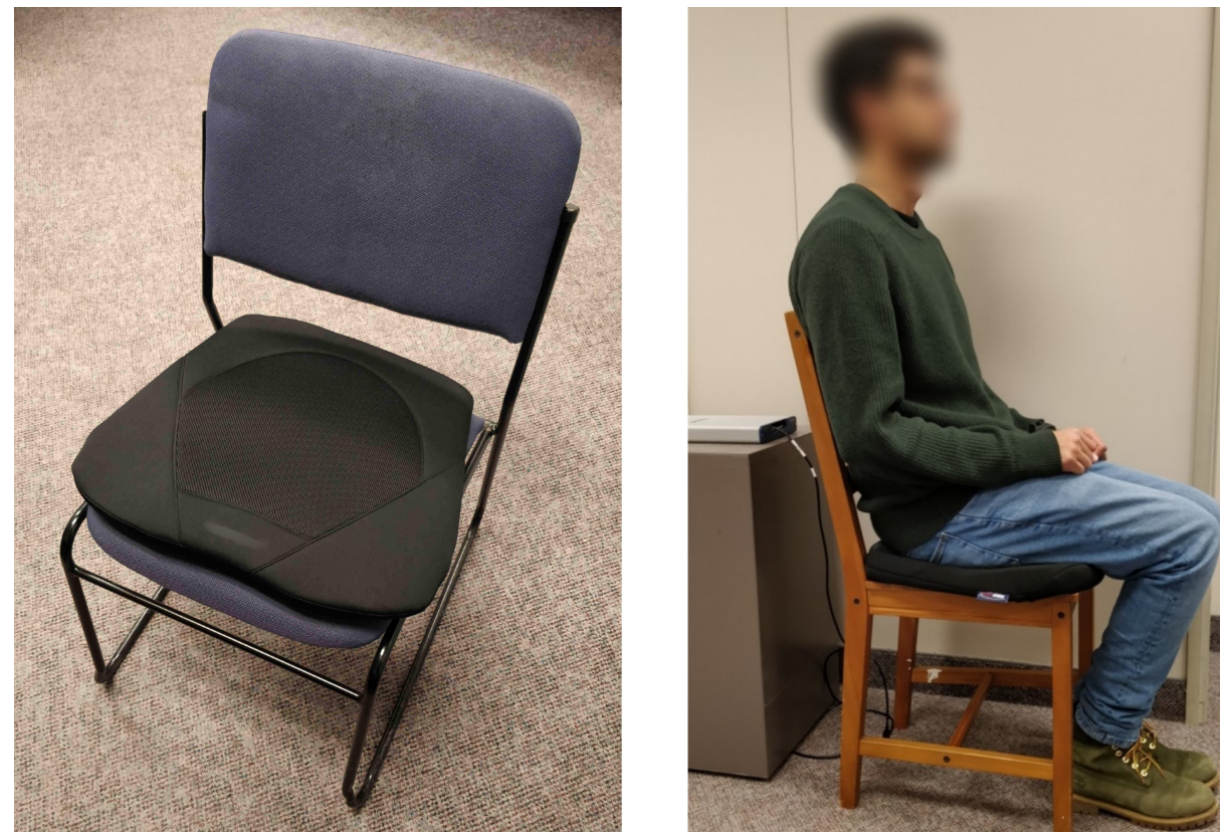
Figure 1. The developed prototype seat cushion (left) and a participant seated on the cushion